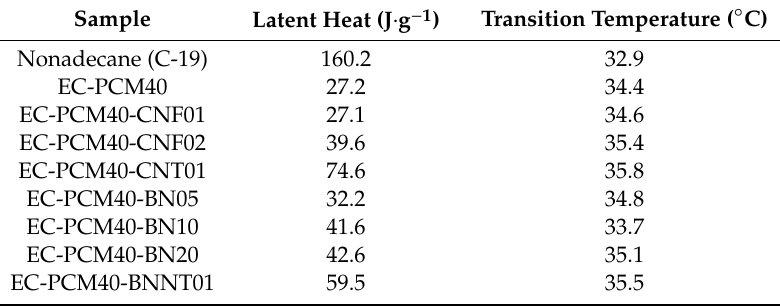
Table 1. DSC analysis results for di ff erent sample